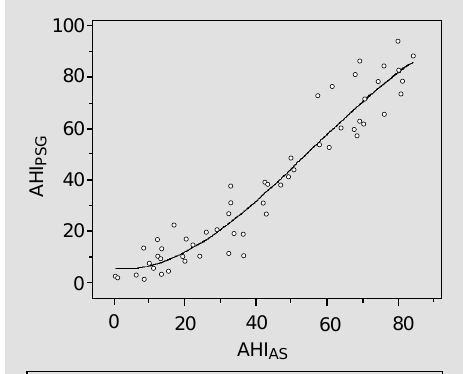
Figure 2 - Differences ( D ) of AHI (PSG-AS) plotted against the mean for each patient. The solid line represents the mean differ- ence and the dashed lines indi- cate the limits of agreement (±2 SD). AHI: Apnea-hypopnea in- dex; PSG: polysomnography; AS: AutoSet™; SD: standard de-